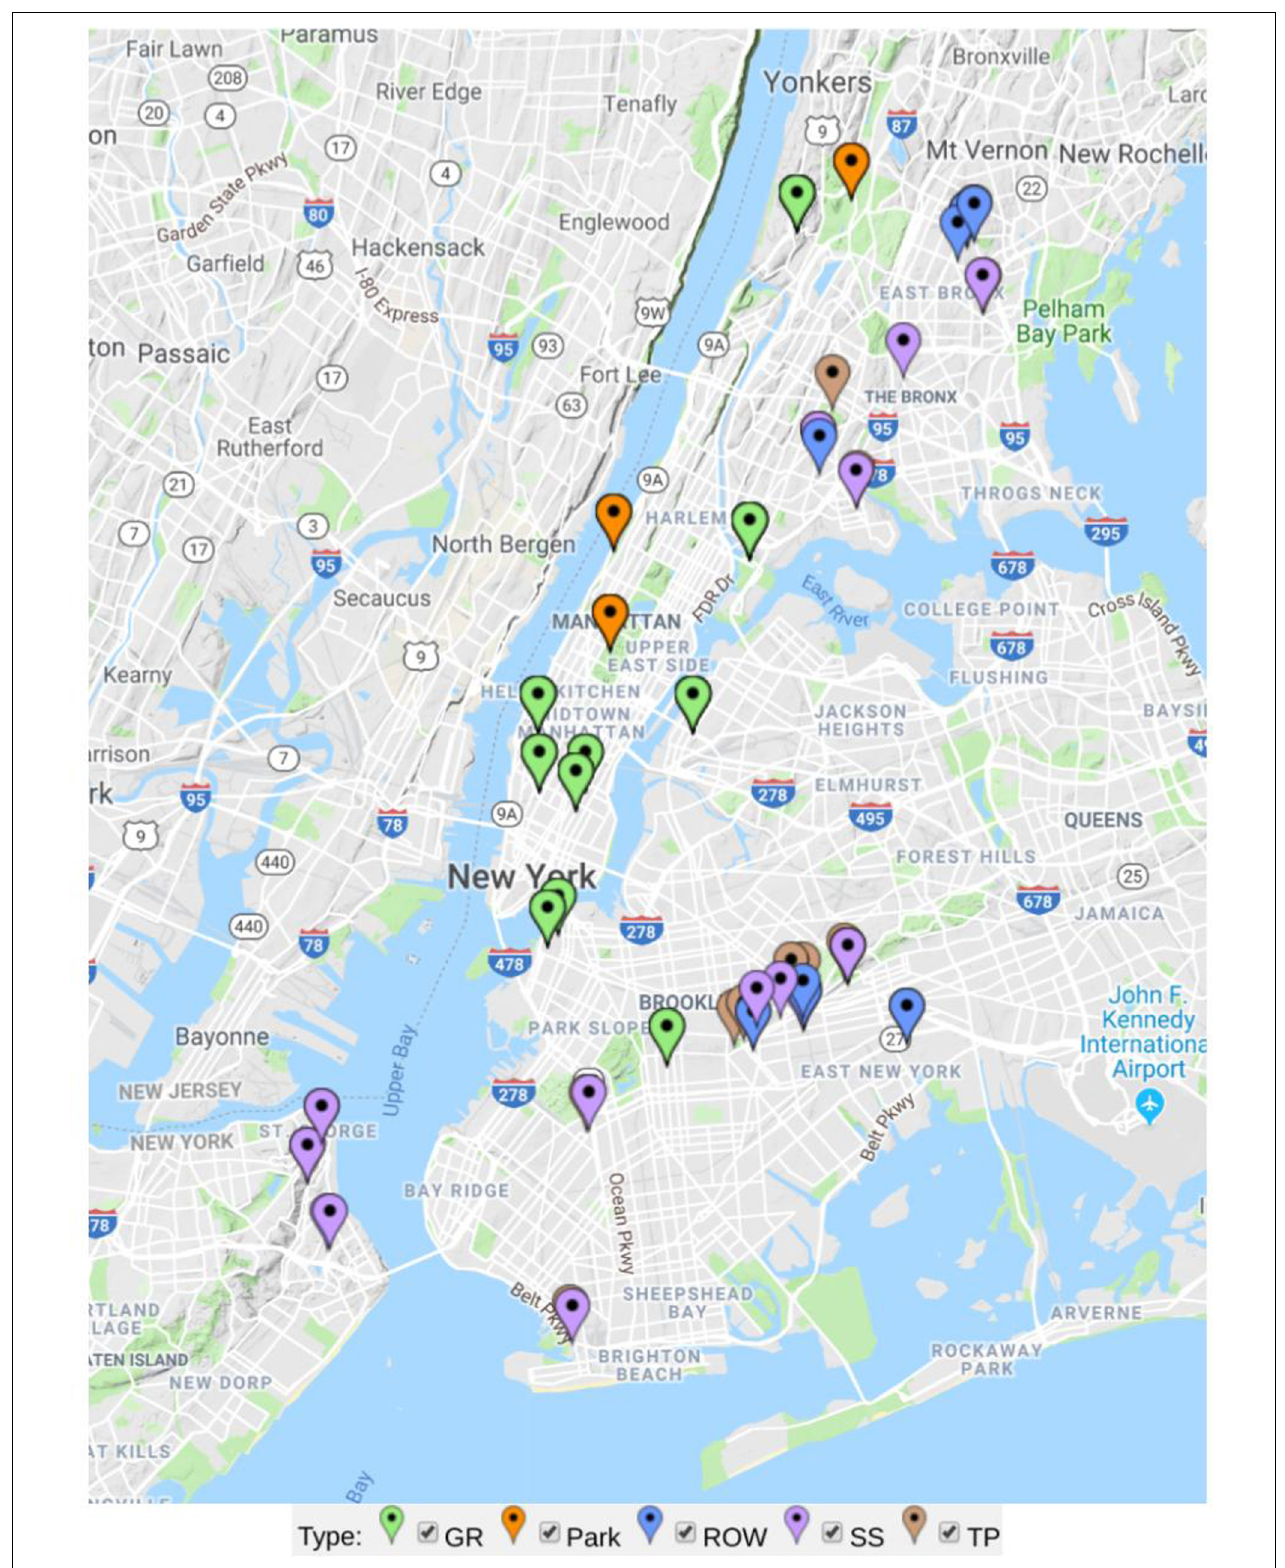
FIGURE 1 | Map of sample sites analyzed in this study separately colored by green infrastructure type (GR in green = green roof, Park in orange = ground-level park lawns, ROW in blue = right-of-way bioswale, SS in purple = streetside infiltration swale, and TP in brown = conventional tree pit).